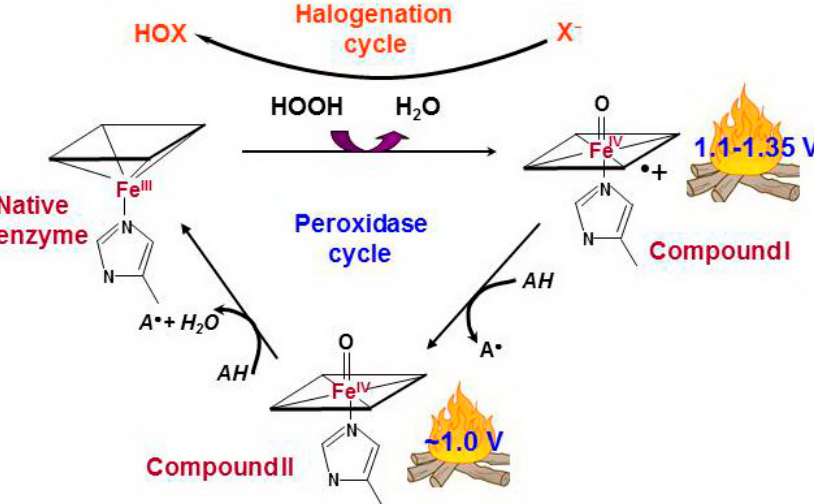
Figure 1. Peroxidase and halogenation cycles of human true peroxidases [34–36]. The interaction between hydrogen peroxide and native ferric peroxidase heme leads to the reduction of H 2 O 2 to water with formation of Compound I which is oxoferryl porphyrin- π -cationic radical. Compound I can be sequentially reduced to the native enzyme via formation of Compound II by two one-electron oxidations caused by a number of simple compounds, peroxidase substrates (peroxidase cycle). AH is a peroxidase substrate that is oxidized with formation of a radical (A • ). Compound I can catalyze the two-electron oxidation of (pseudo)halides, thus completing the so-called halogenation cycle. X − stands for halide ions (Cl − , Br − , I − ) and thiocyanate ions (SCN − ). HOX is the corresponding (pseudo)hypohalous acid.